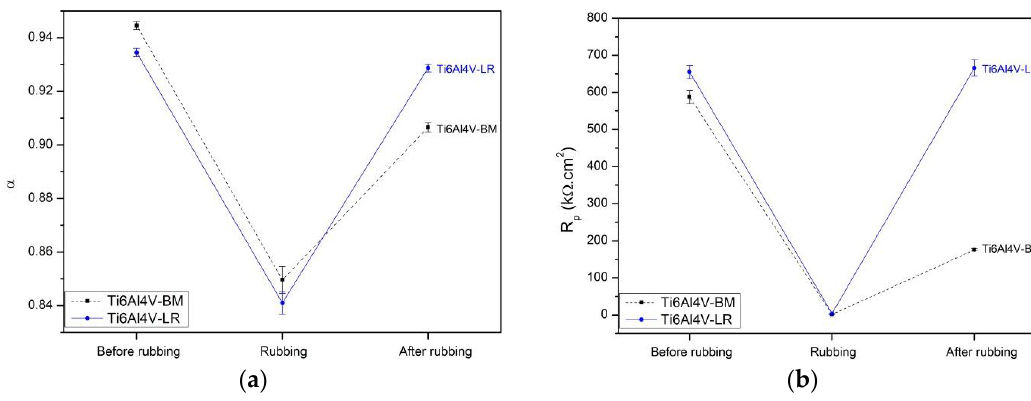
Figure 14. Effect of friction on the electric circuit parameters before, during, and after rubbing: ( a ) alpha and ( b ) polarization resistance.